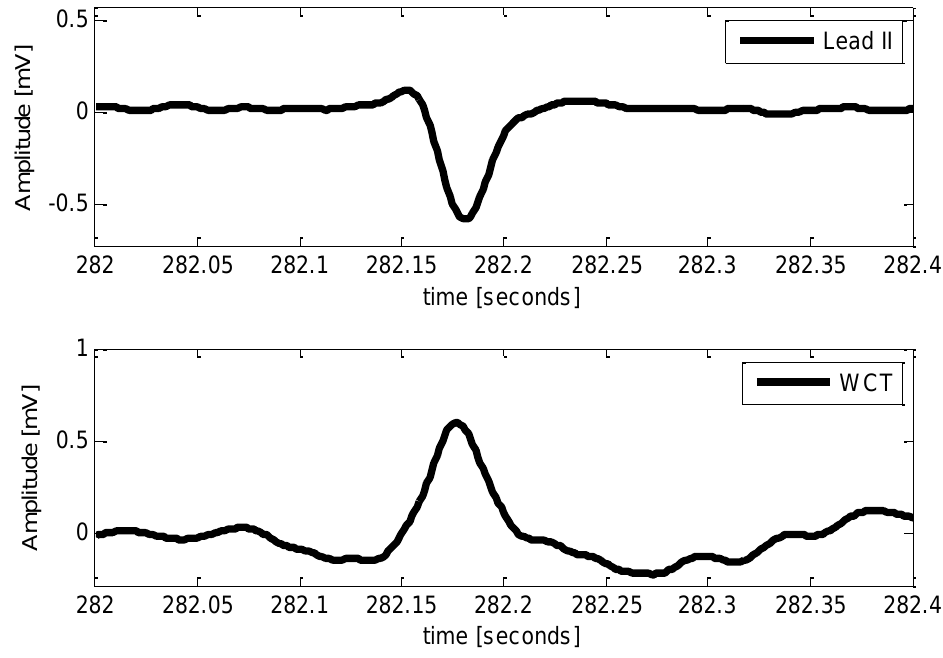
Figure 5. Example of positive deflection WCT. WCT is 100% of lead II amplitude (average); recording is from an 82-year-old female patient admitted from the emergency department (unconfirmed diagnosis).